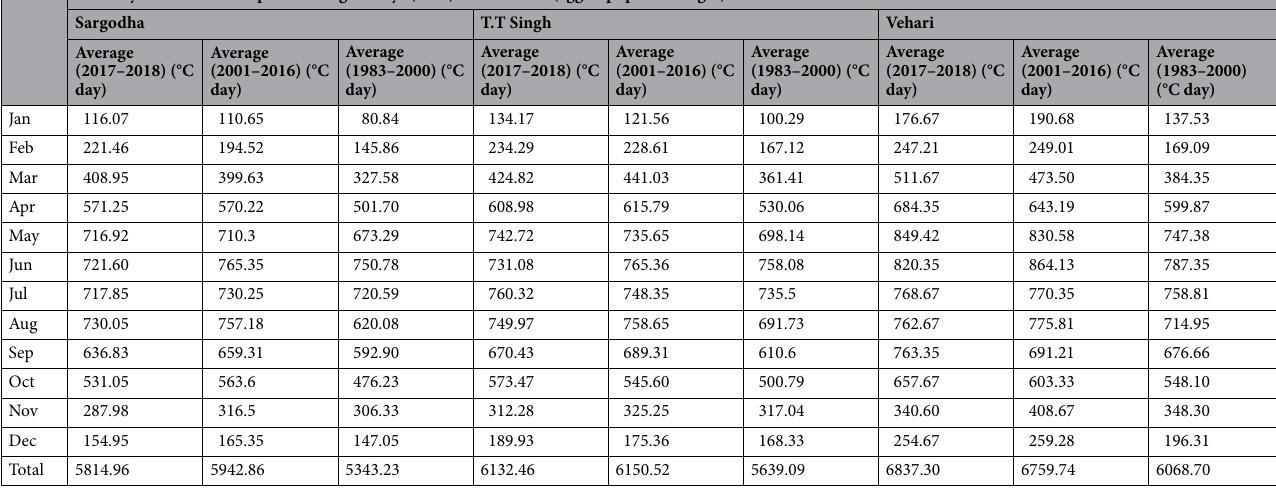
Table 2. Monthly basis DDs computation of three